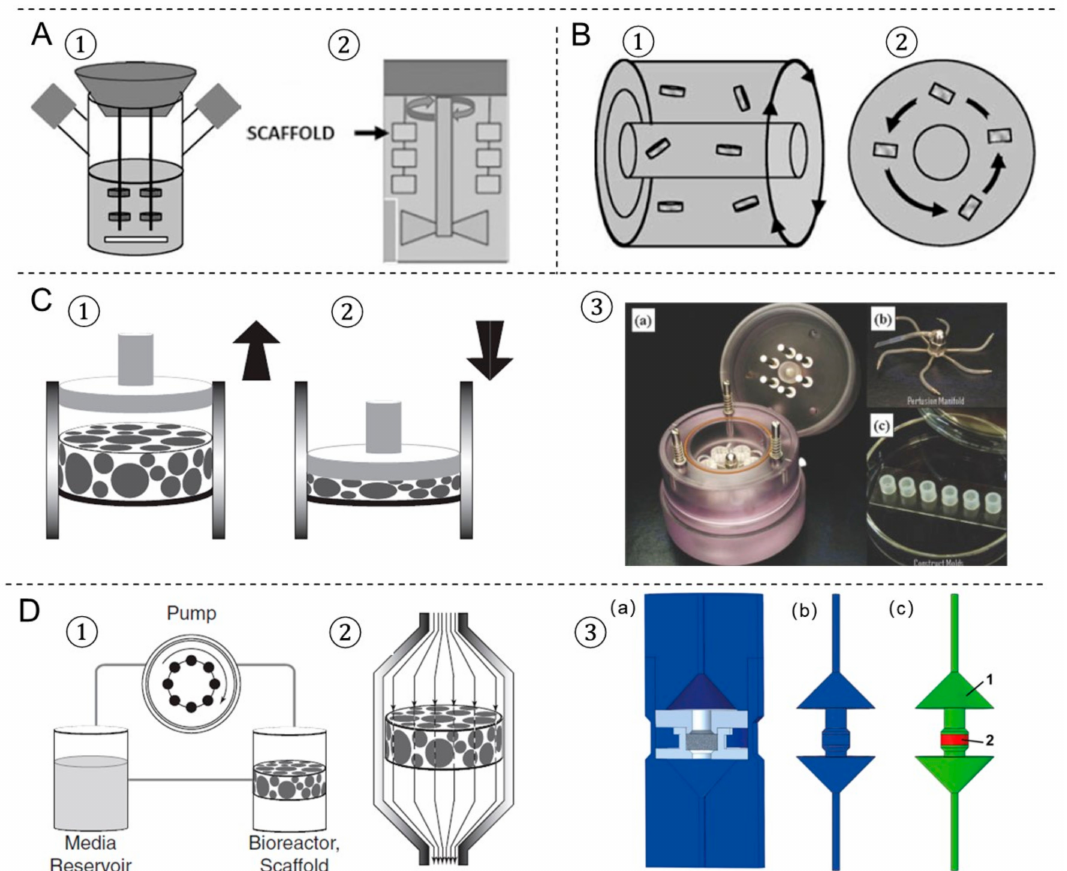
Figure 2. The four most prevalent bioreactors used in tissue engineering. ( A ) Spinner flask bioreactor using a magnetic stir bar ( 1 ) or a shaft ( 2 ). ( B ) Rotating wall vessel bioreactor in different views ( 1 , 2 ). ( C ) Compression bioreactor: a piston applies a direct dynamic compression load on the scaffold construct, ( 1 ) release, ( 2 ) load. ( 3 ) A bioreactor system of dynamic mechanical stimulation for engineered cartilage constructs, ( a ) at the bioreactor base is a culture medium reservoir, ( b ) the lid of the bioreactor, ( c ) the engineered constructs are molded into cylindrical plugs. ( D ) Perfusion bioreactor: ( 1 ) the perfusion system consists of a pump, a media reservoir and the bioreactor housing the scaffold; ( 2 ) the scaffold is press-fitted into a perfusion chamber to ensure medium flow through the scaffold. ( 3 ) Schematic bioreactor drawings of an in-house designed perfusion bioreactor for engineered bone tissue. ( a ) 3D computer-aided design model, ( b ) inverted volume of perfusion bioreactor, ( c ) material definitions for computational fluid dynamics model. Picture modified with permission from reference